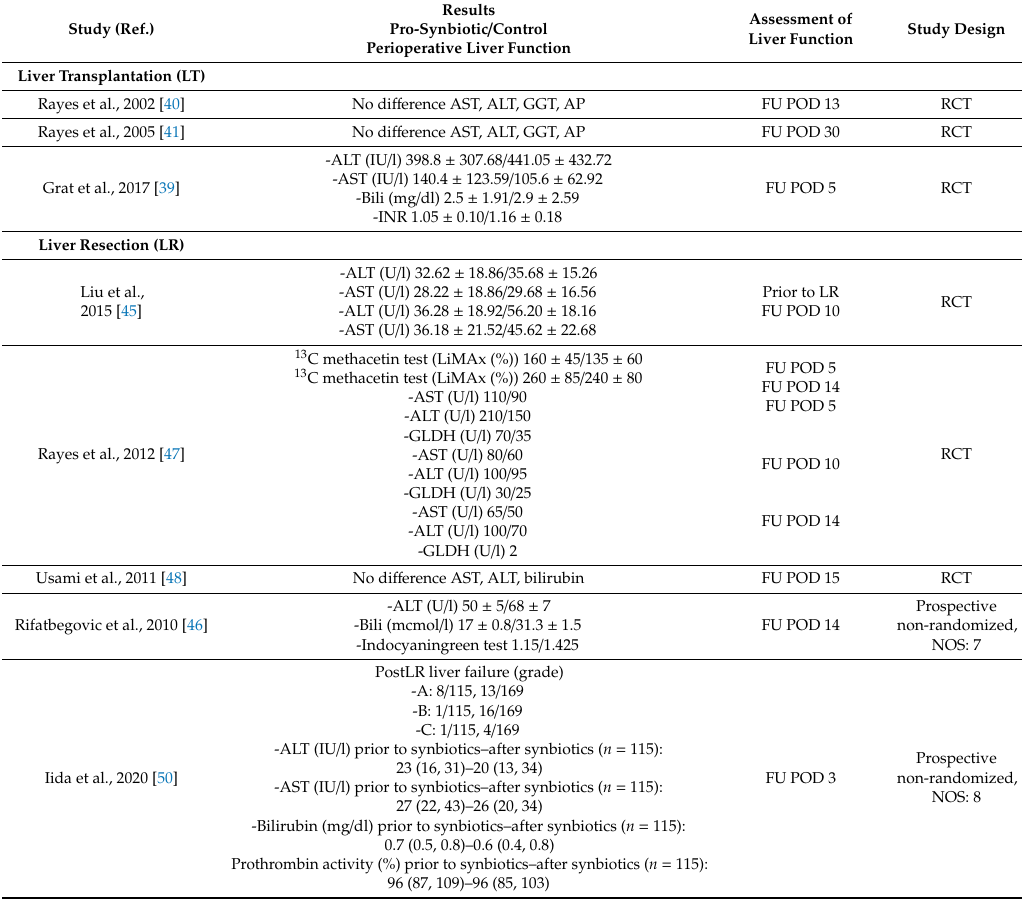
Table 2. Studies on perioperative pro- / synbiotics and their e ff ect on liver function. Study